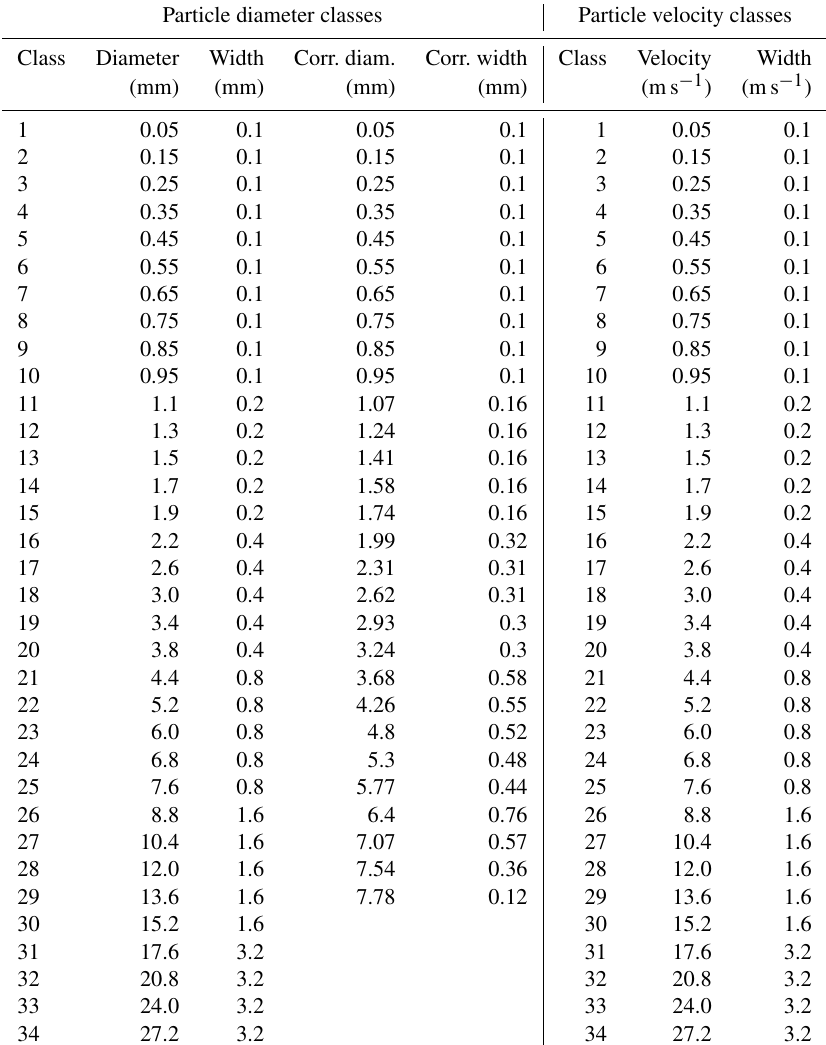
Table 1. Definition of the classes of particle size and velocity for the